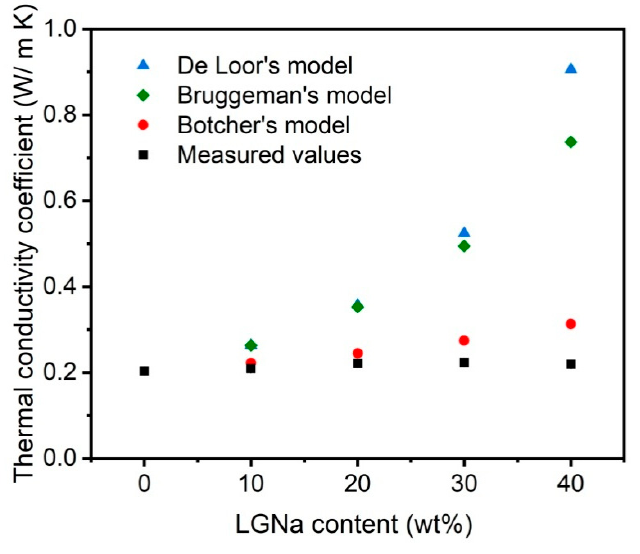
Figure 4. Thermal conductivity coefficients for PP with different contents of LGNa compared with theoretical models.